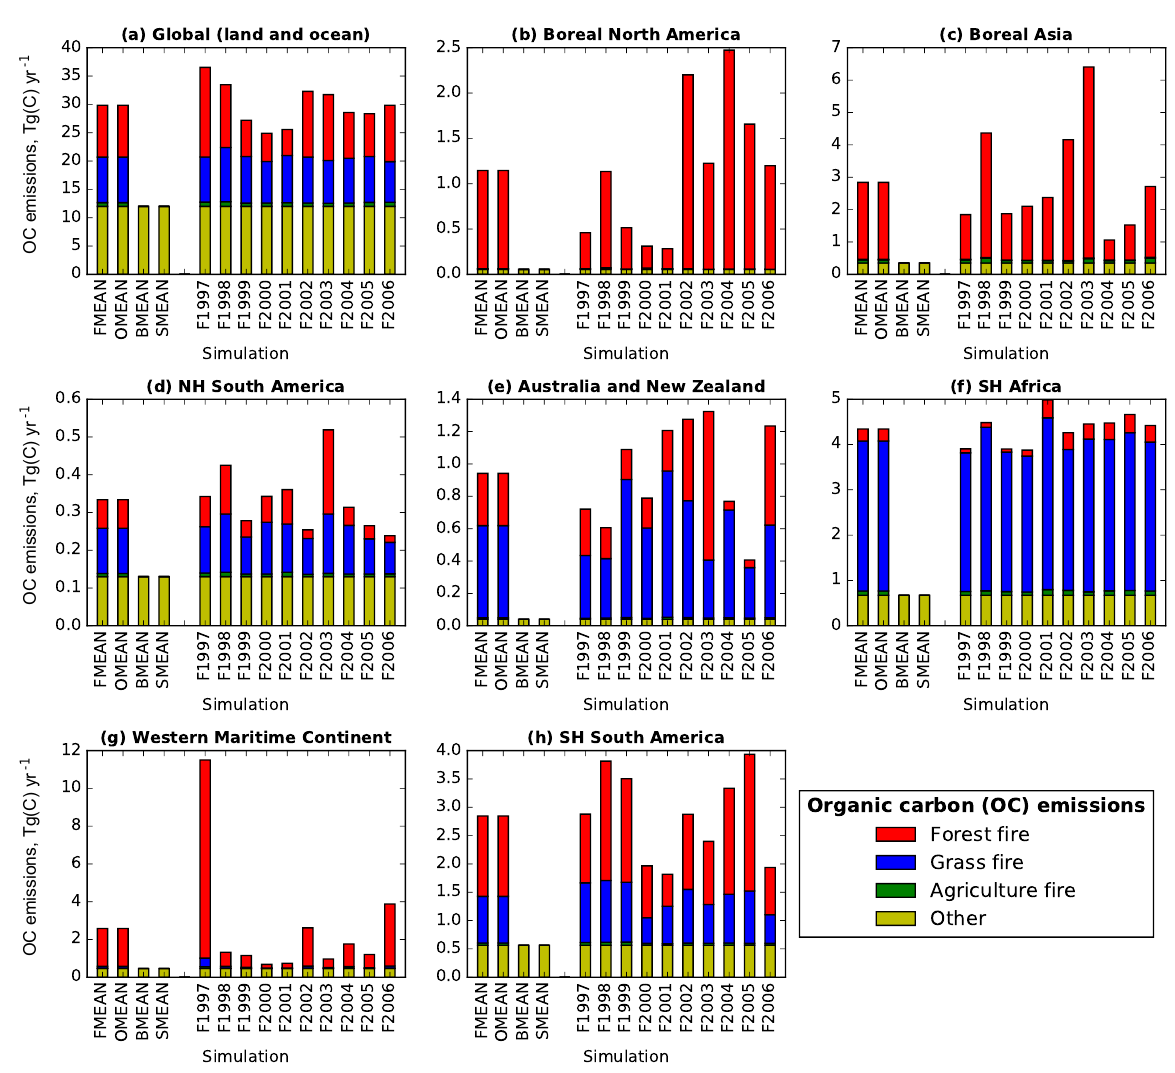
Figure 2. Organic carbon (OC) aerosol annual emissions for (a) the globe and (b–h) seven regions (see Fig. 1). The seven regions included here are those with the largest FMEAN–F0 net radiative flux perturbation differences (Table 1). “Other” refers to year-2000 emissions from non-fire sectors, such as domestic emissions and fossil fuel emissions from industry. Organic carbon emissions for another eight regions are shown in Fig. S1. Black carbon and sulfur dioxide emissions are shown in Figs.